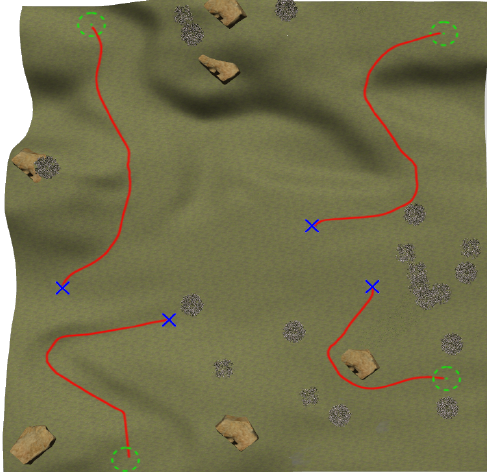
Figure 16. Navigation tests after the third training stage. The moving average with 1000 time steps of the reward function along the 200 training episodes ¯ r t is shown in Figure 17. The average duration of each episode was 83.4 s, 78.6 s and 94.6 s for the first, second and third stages, respectively. In the first stage, it can be observed that learning is achieved very quickly by improving ¯ r a improvements require more training steps and involve the reduction of ¯ r r shows a slow and slightly positive evolution of ¯ r t .